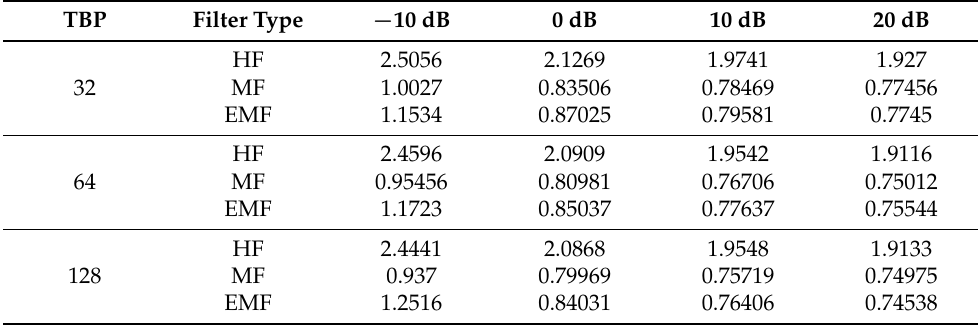
Table 1. Impulse response width (IRW) for HF, MF, and the proposed EMF.